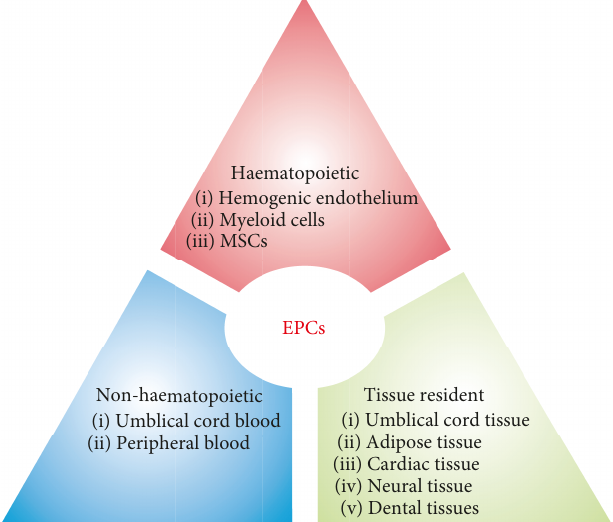
Figure 3: Di ff erent sources of EPCs.